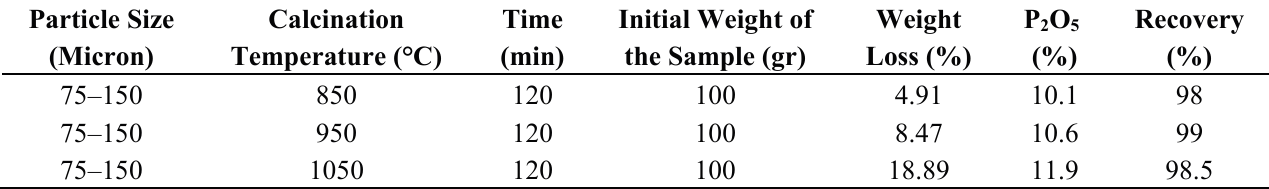
Table 4. Results of calcination test for the fractional class of 75–150 μ m.